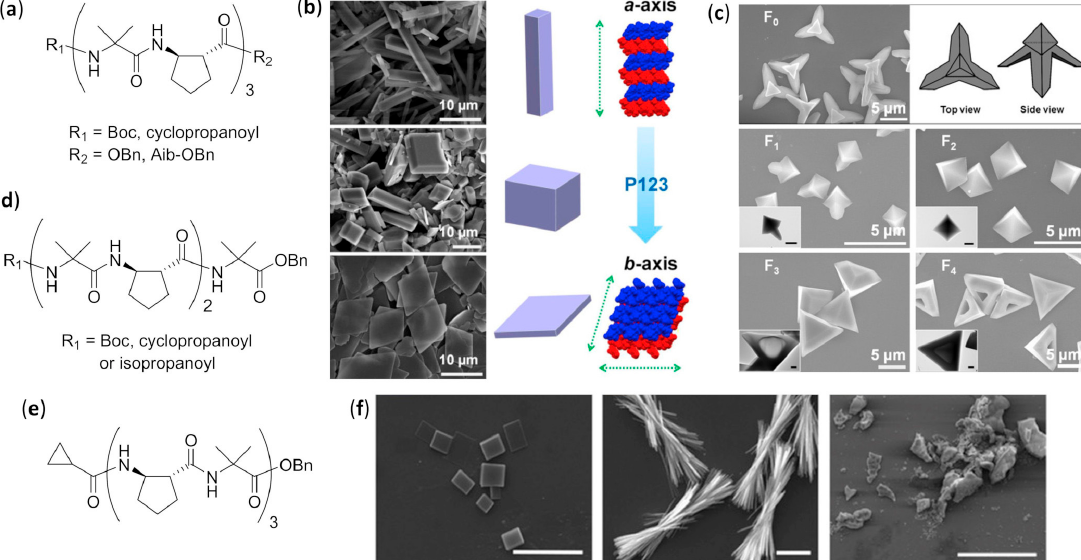
53 of 69 encapsulate different fluorescent guests (quantum dots, Rhodamine B, and green fluorescent protein) in a guest-independent manner and without changing the morphology. In addition, when stock solutions in THF or methanol containing the equimolar mixtures of both enantiomers of Boc-(Aib-ACPC) 3 -Aib-OBn, depicted by R 2 = Aib-OBn in Figure 24a, were added to aqueous P123 (24 g L − 1 ), foldectures different from those obtained from pure enantiomers were generated [263]. Performing experiments with non-equimolar stock solutions, the authors also demonstrated that interactions between mirror images were favored with respect to those among molecules with the same chirality, because two distinct morphologies—one for the equimolar mixture and the other for the excess of pure enantiomer—could be separately observed. An extensive